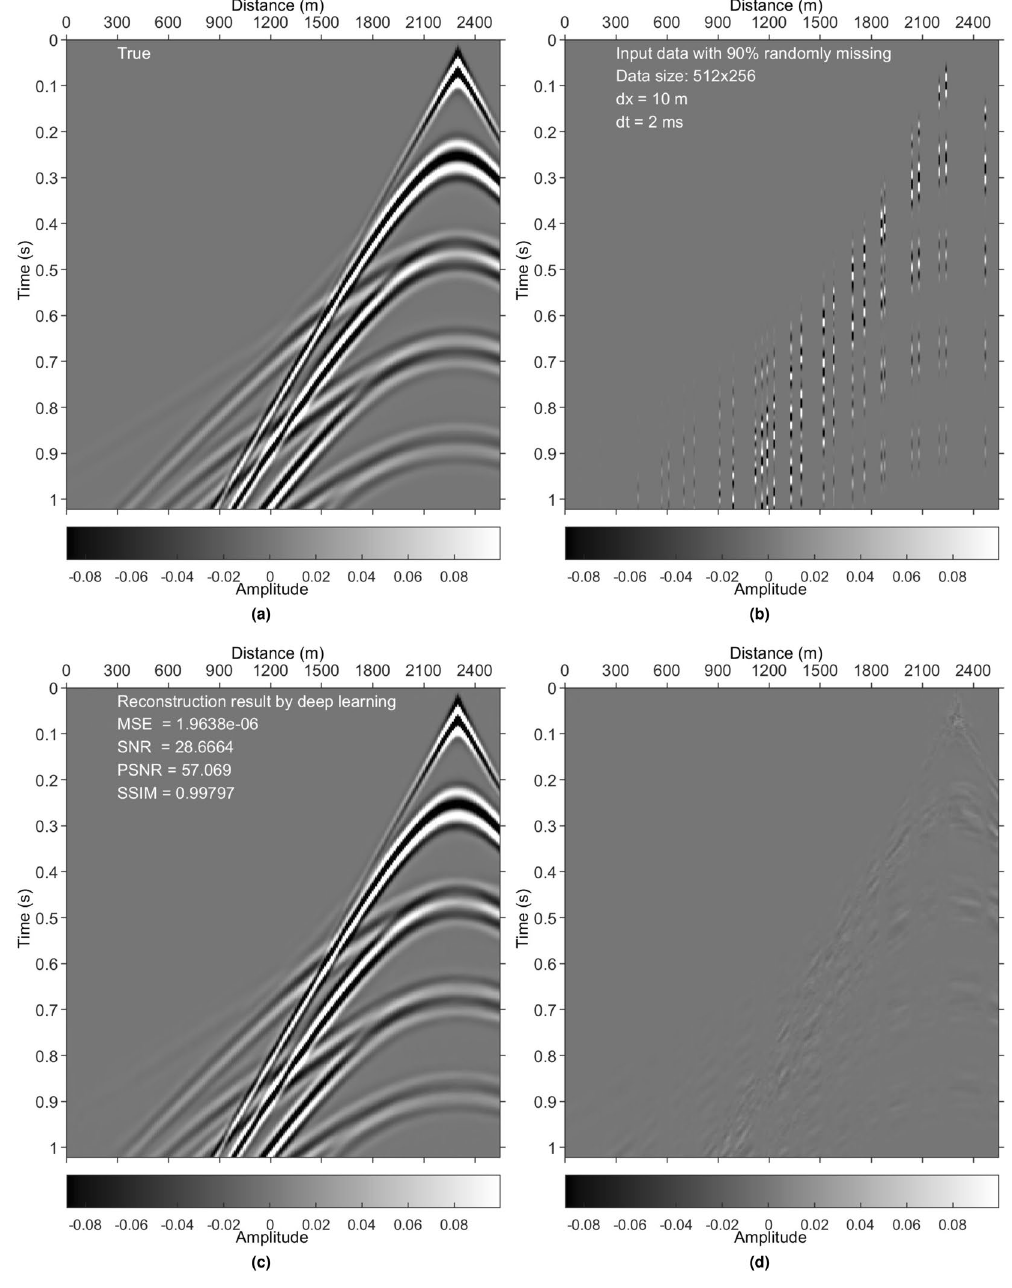
Figure 4. Results on a synthetic training data set. ( a ) True data (a common-shot-point, CSP, gather). ( b ) Irregularly sampled data with 90% missing. ( c ) DL reconstruction result. ( d ) Difference between ( a , c